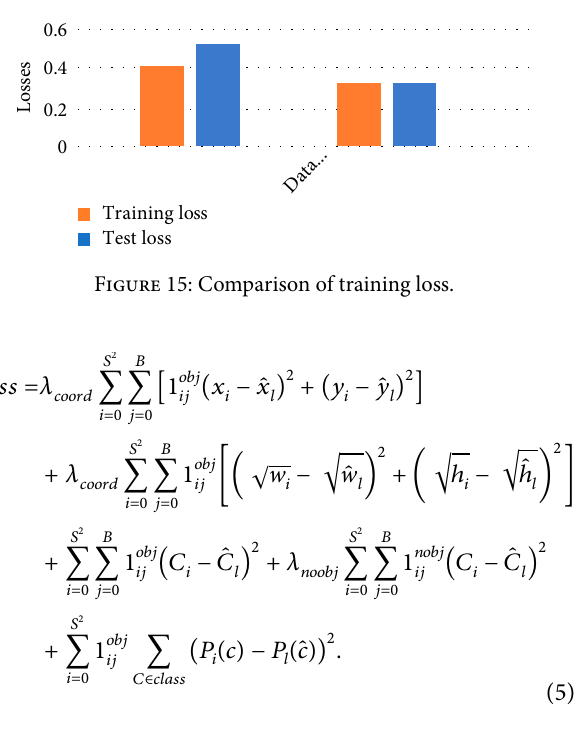
Figure 14: Enhancement of identification accuracy with data augmentation.